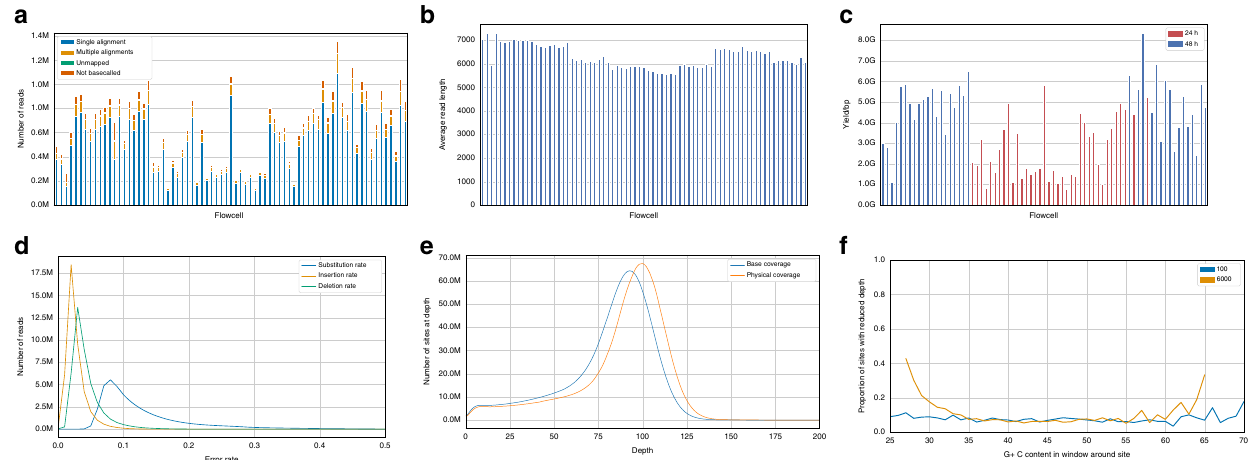
Fig. 1 Characteristics of sequencing using ONT for NA12878. a Yield per fl ow cell, with fl ow cells organized left to right by run date. The total size of the bar represents the number of reads from each fl ow cell and is split into the proportion of reads that have been mapped in a single alignment (single alignment), mapped in multiple alignments (multiple alignments), have been base-called, but not been mapped (unmapped) and reads that have not been base-called (not basecalled). b Average read length per fl ow cell. c Yield (base pairs) per fl ow cell. d Distribution of per-read substitution, insertion and deletion error rates in the high-quality read set. e Distribution of genomic coverage. f Proportion of sites with a read depth less than 40 binned by G + C content of the surrounding window. Shown are read depth in windows of size 100 bp and 6000